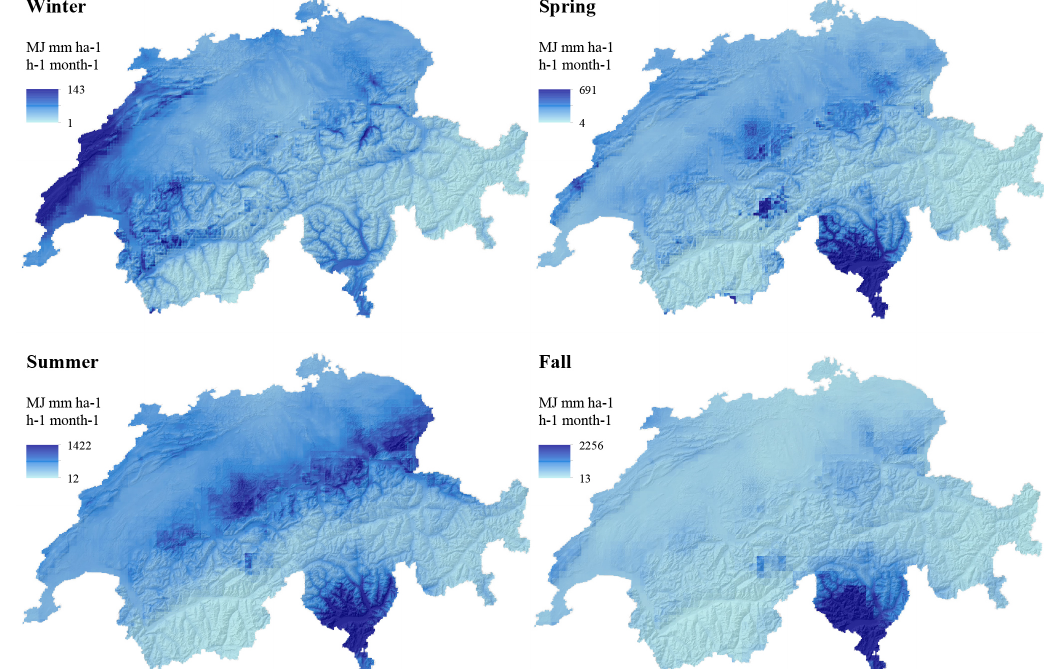
Figure 4. Seasonal rainfall erosivity maps for Switzerland derived by regression–kriging. The following months were averaged to derive seasonal maps: winter (December–February), spring (March–May), summer (June–August), fall (September–November).